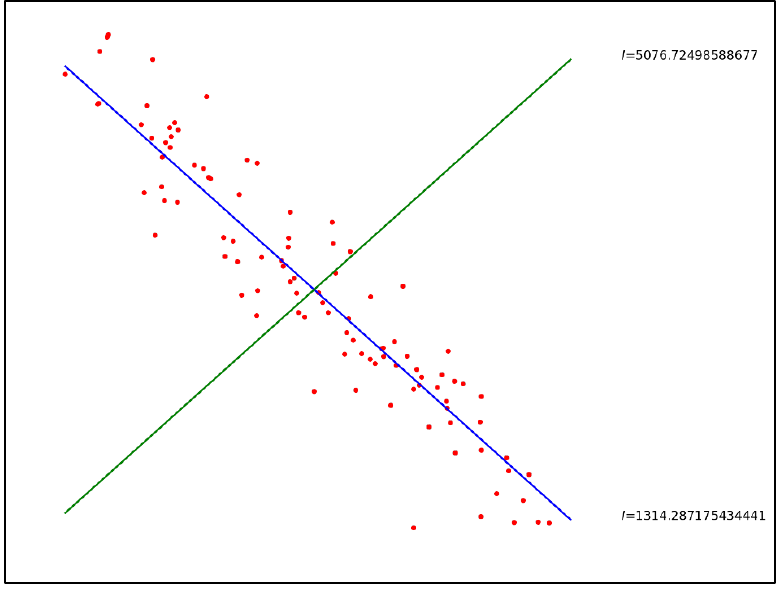
Figure 15. Length axis and width axis. Red points represent detected distress area points. The axis with the largest moment of inertia (the green axis) is considered as the width axis. The axis with the smallest moment of inertia (the blue axis) is considered as the length axis.